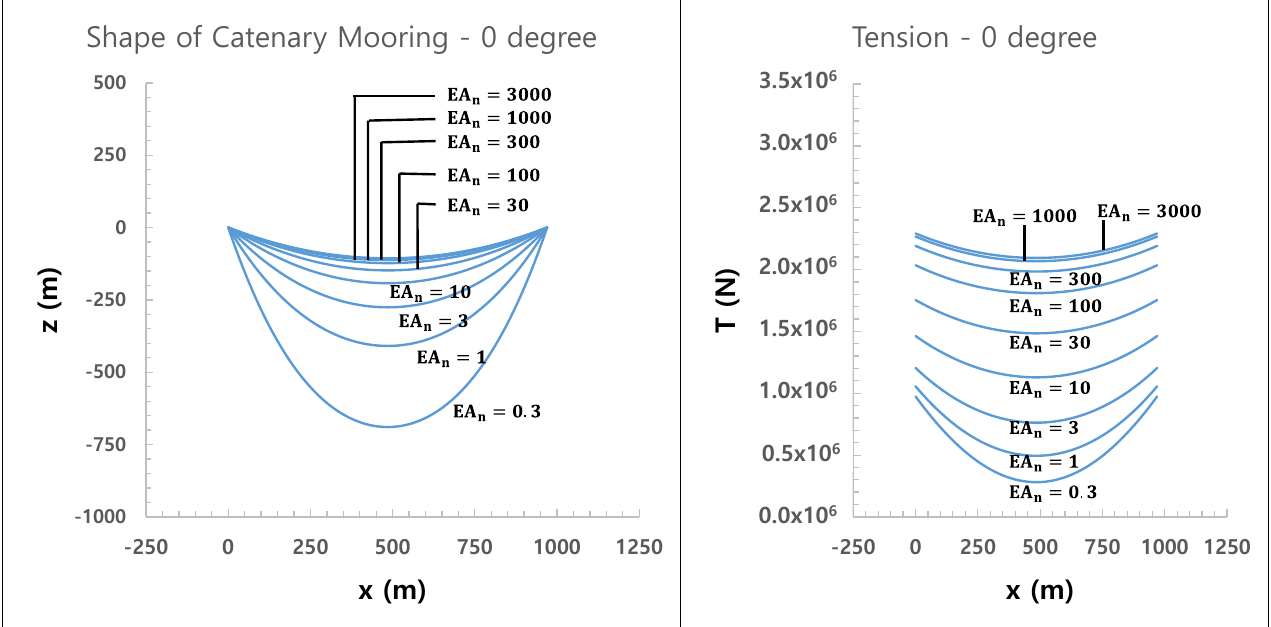
Figure 5. Results for static analysis of mooring line when q is 0°.